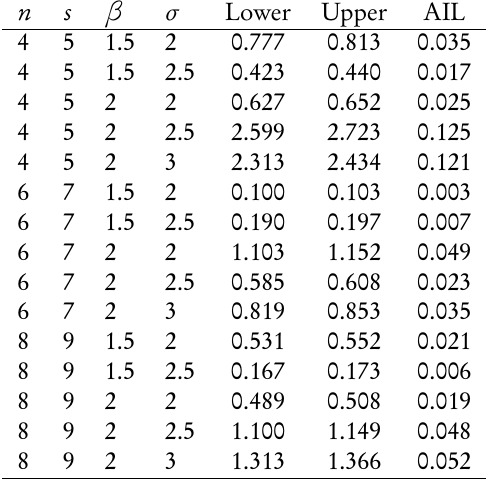
The lower and upper bound for st h record and AIL for k = 3